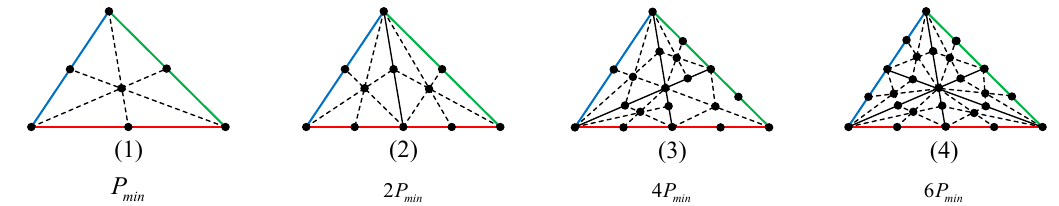
Figure 11. Every line in this figure is a median of triangular faces. When the perimeter of a triangle exceeds double, use the next sampling method. The lengths of the edges in this illustration are red > green > blue. Triangle (3) is set as standardized sampling, which is the average perimeter of all faces on surfaces, and triangle (4) represents a rearrangement of a triangular face into six individuals.